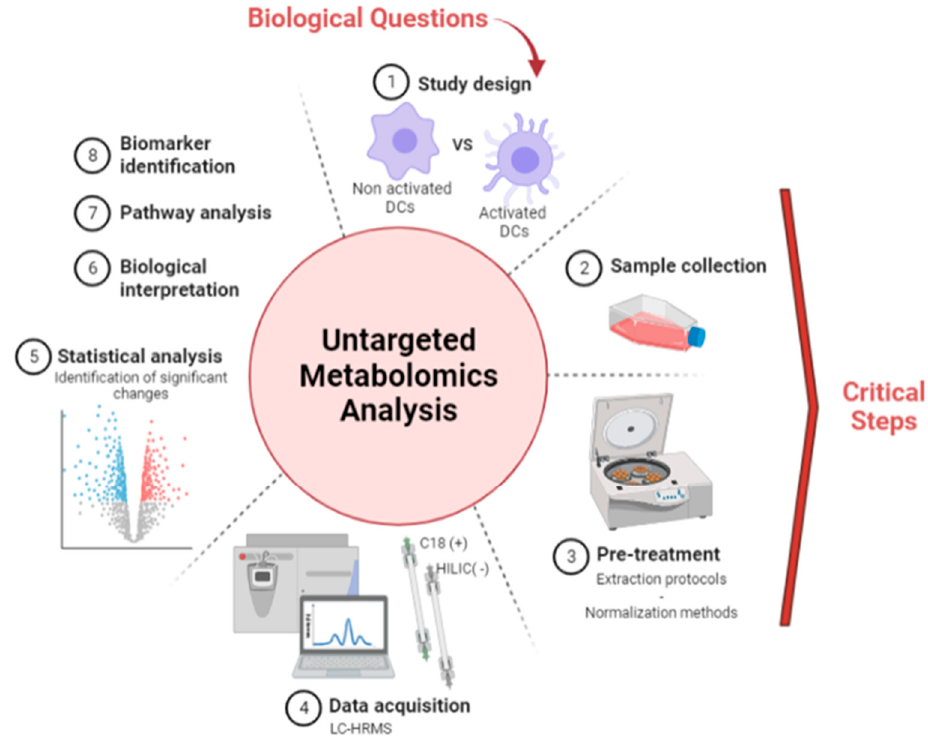
Figure 1. Untargeted metabolomics workflow applied to the study of DCs. Figure made with BioRender.com.